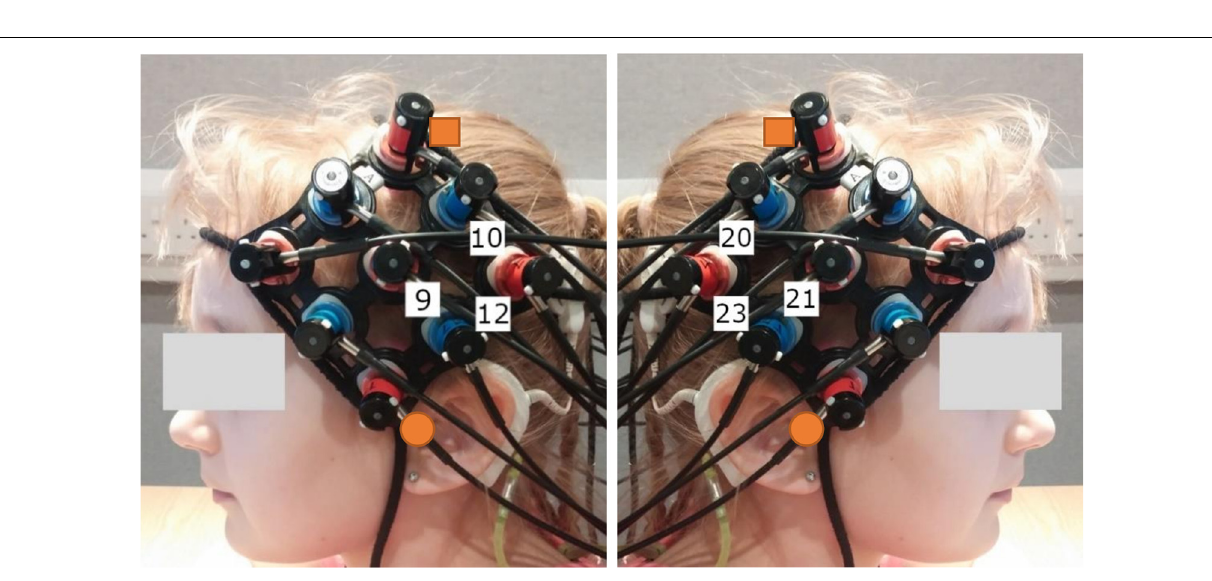
applied using a wavelet filtering technique using the HOMER2 hmrMotionCorrectionWavelet function (Molavi and Dumont, 2012). Wavelet coefficients lying more than 0.719 times the